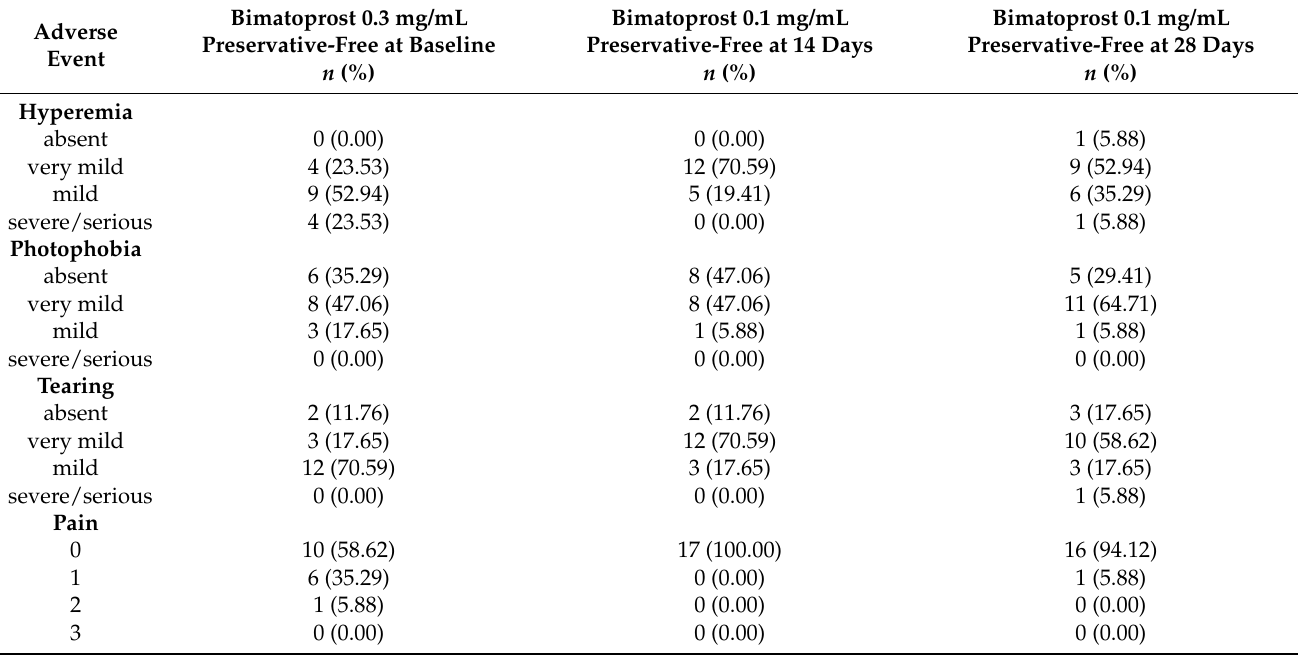
Table 6. Adverse event totals recorded between Bimatoprost 0.3 mg/mL preservative-free at baseline and Bimatoprost 0.1 mg/mL preservative-free at 14 and 28